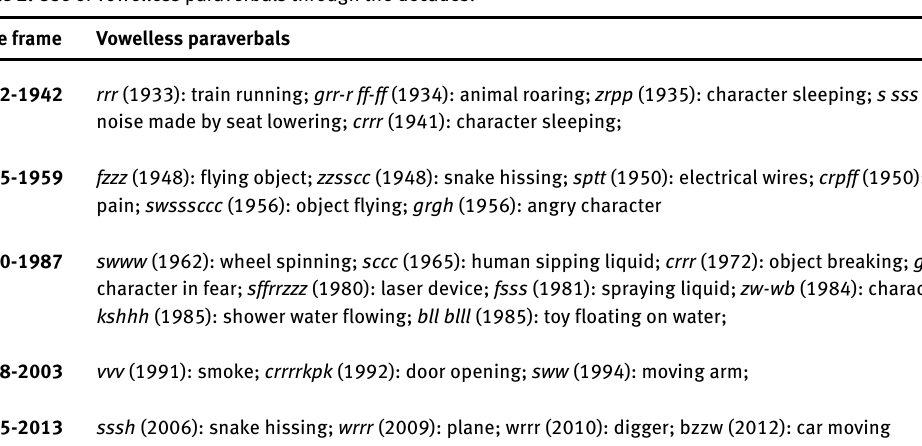
Table 2. Use of vowelless paraverbals through the